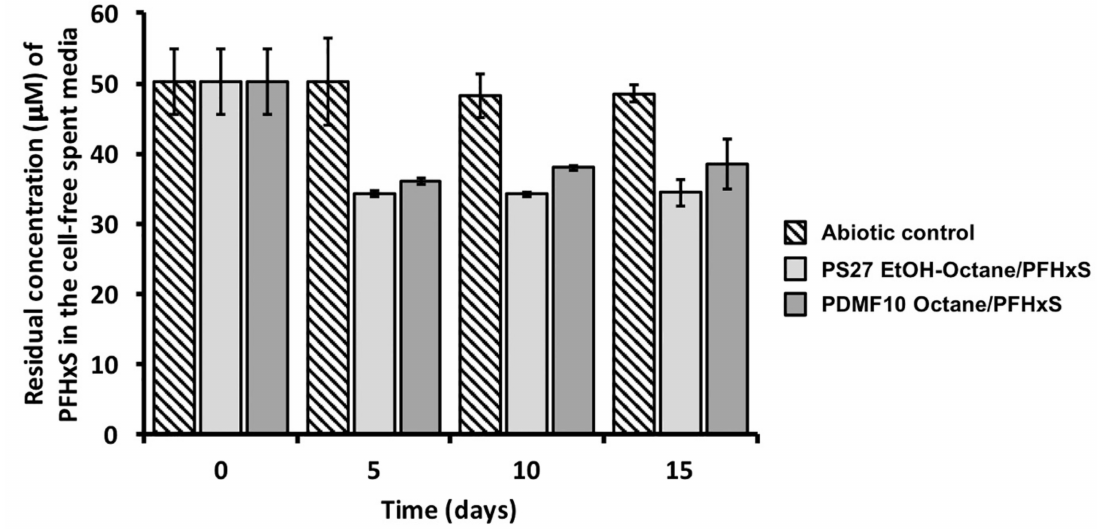
Figure 5. Removal e ffi cacy of PFHxS performed by PS27 and PDMF10 resting cells under ethanol-octane and octane conditioning,